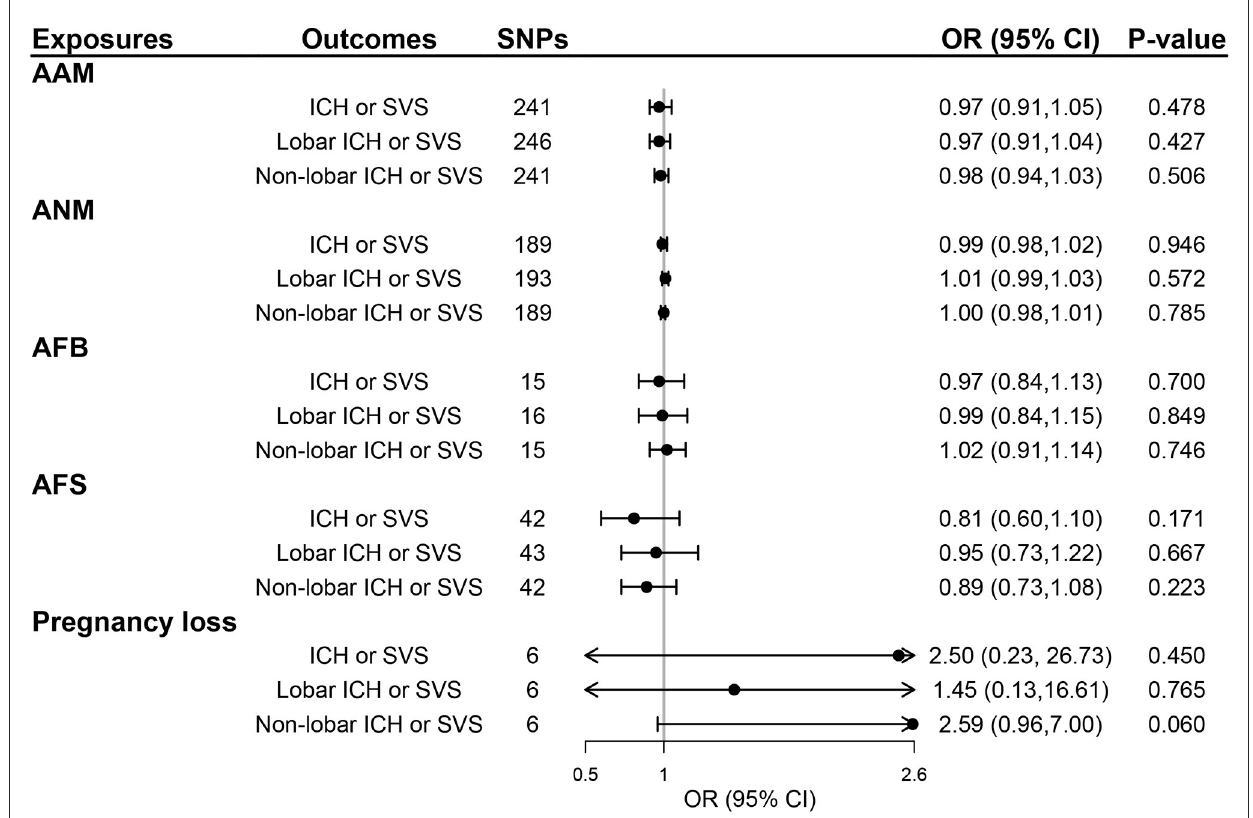
Table 1. For estradiol with only one SNP available, we